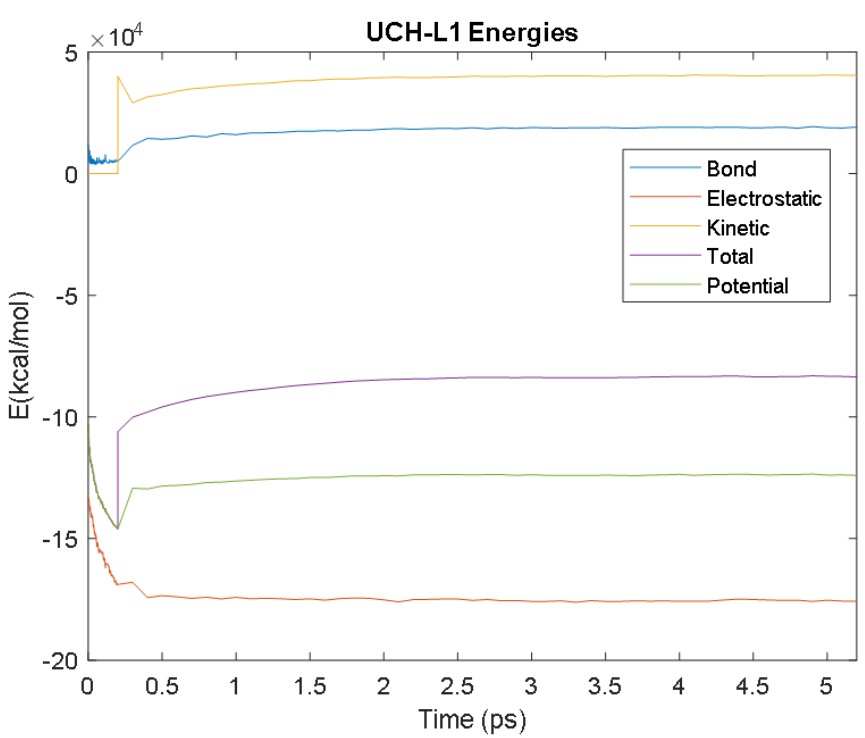
Figure 30. A plot of UCH-L 1′ s bond, electrostatic, kinetic, total, and potential energies.